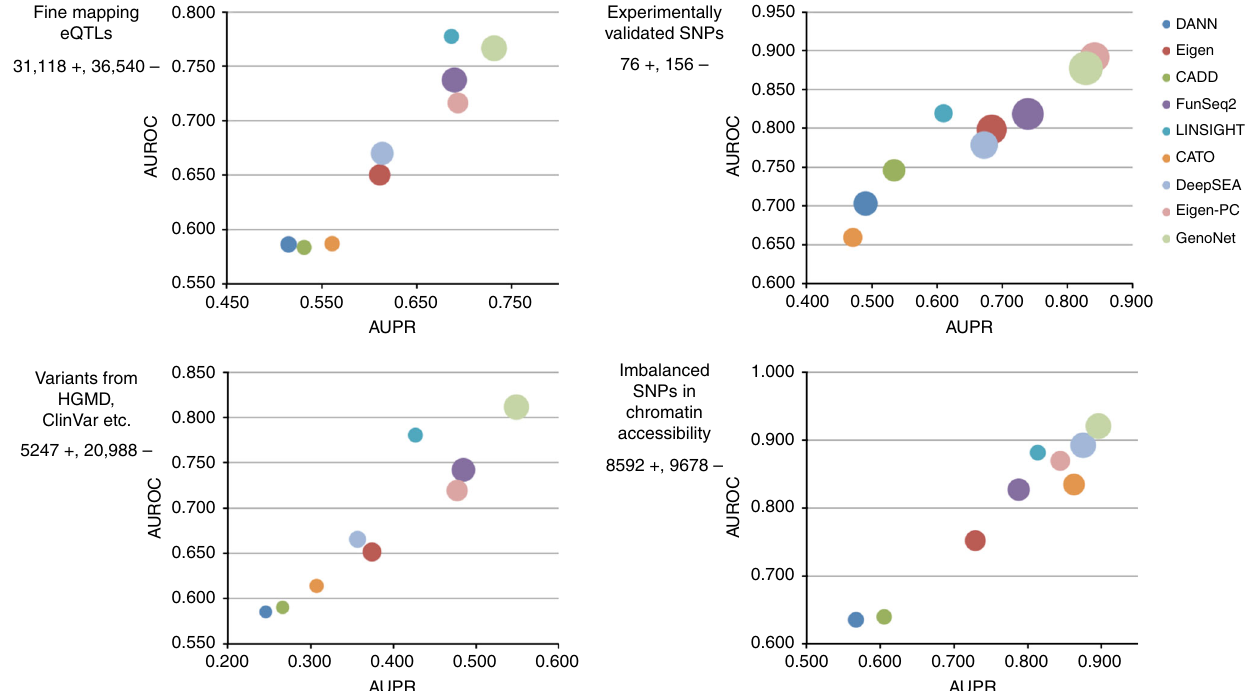
Fig. 3 Organismal-level prediction of regulatory variants. Each fi gure presents the AUPR (area under the precision recal curve), AUROC (area under the receiver operating characteristics curve), and COR (Pearson correlation between predicted and true labels) for different organism-level prediction methods. X axis presents AUPR; Y axis presents AUROC; the bubble size presents COR. Fine mapping eQTLs: Uniformly processed fi ne-mapping eQTLs from 11 studies (31,118 positive variants, 36,540 control variants); Experimentally validated SNPs: manually curated experimentally validated regulatory SNPs (76 positive variants, 156 control variants); Re fi ned causal SNPs: re fi ned causal SNPs in the non-coding regions from different resources including HGMD, ClinVar, OregAnno, and variants from fi ne-mapping candidate causal SNPs for 39 immune and non-immune diseases (5247 positive variants, 20,988 control variants); Allelic imbalanced SNPs: allelic imbalanced SNPs in chromatin accessibility using a large number of DNase-seq assays